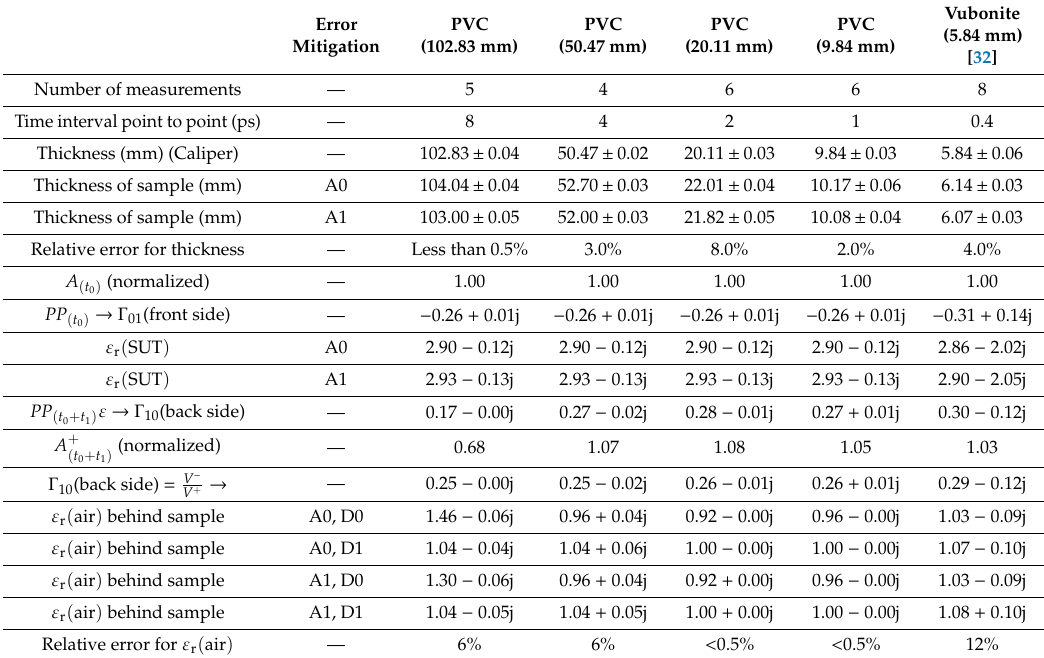
Table 1. Experimental results for single-layer structures with compensating error sources in